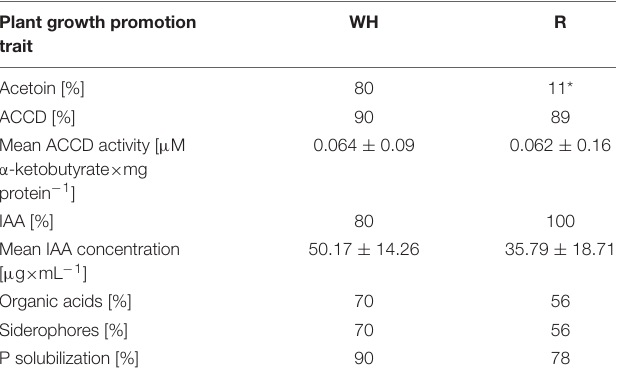
TABLE 3 | Potential plant-growth-promoting traits of R. leguminosarum bv. trifolii strains isolated from nodules of T. repens from the metal-polluted waste heap (WH) and non-polluted reference grassland